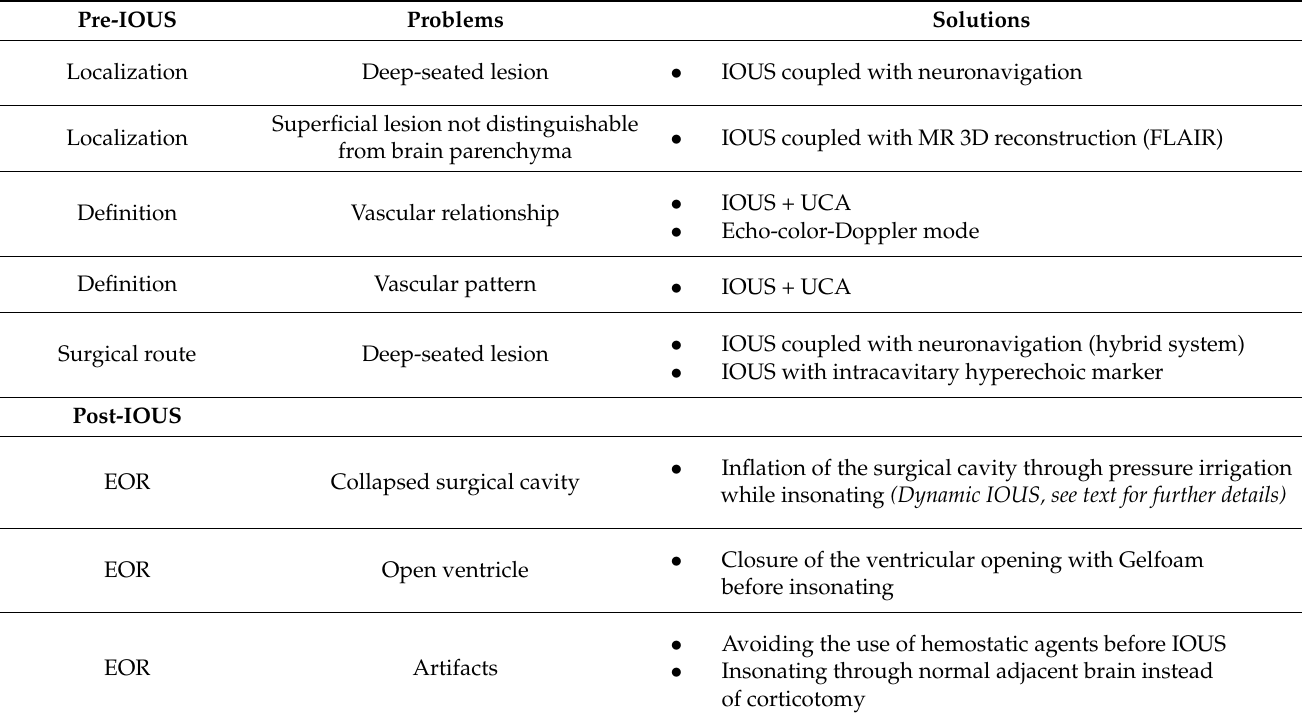
Table 2. Technical limits of IOUS and strategies to enhance its